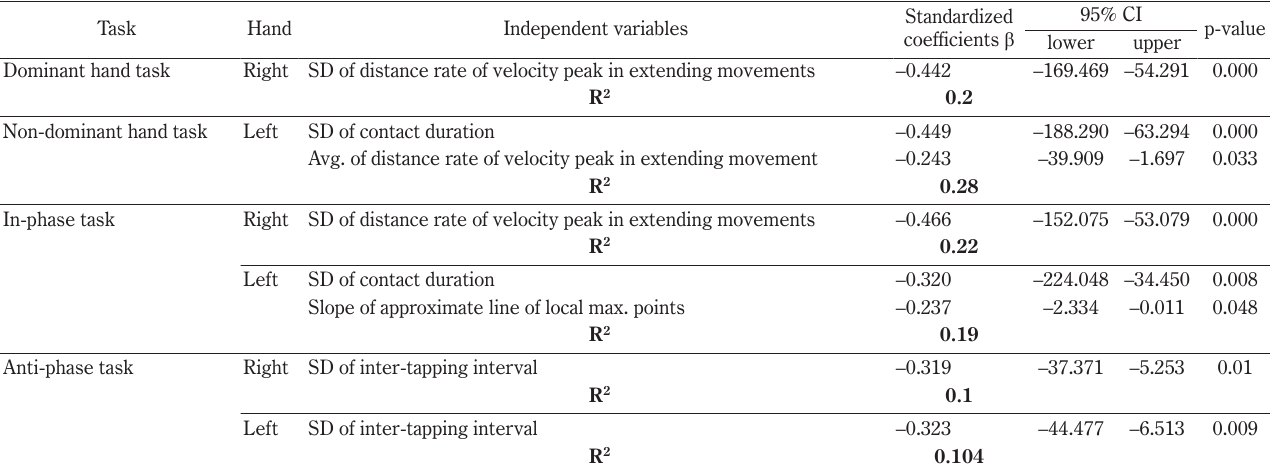
Table 4 Results of multiple regression analysis with MMSE score as the dependent